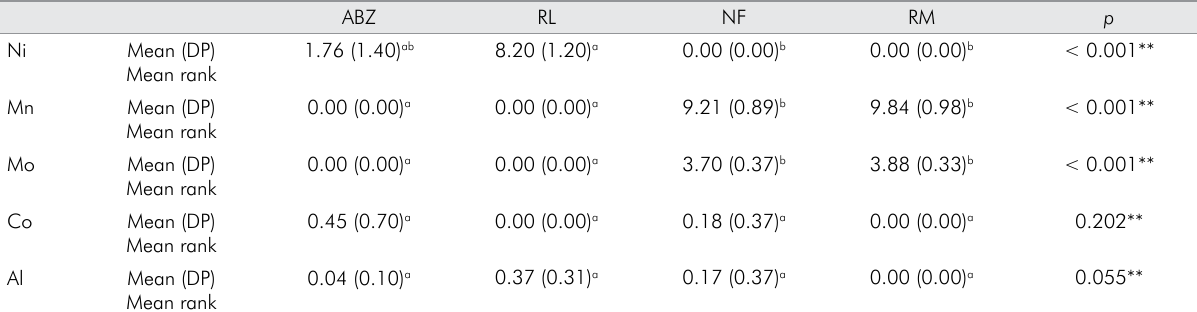
Table 2. Means and standard deviation. Ranks for percentages of Nickel (Ni), Manganese (Mn), Molybdenum (Mb), Cobalt (Co) and Aluminum (Al), according to the bracket group